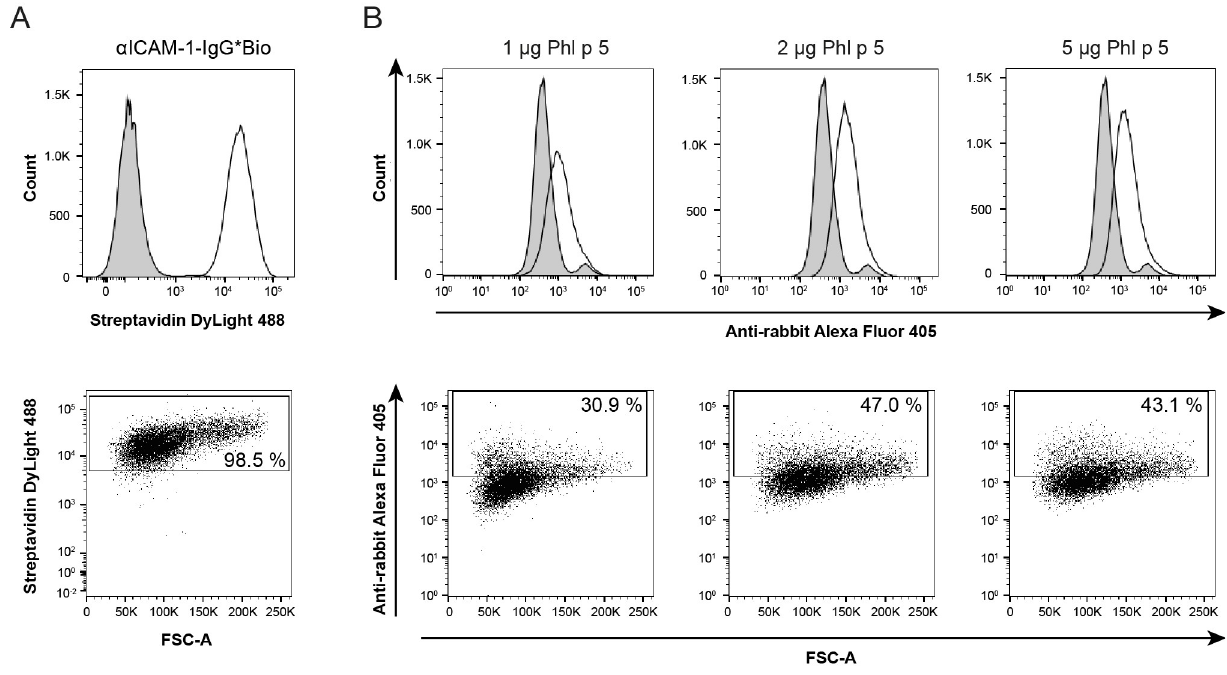
Figure 2. Detection of ICAM-1 or Phl p 5 captured by α Phl p 5/ α ICAM-1 conjugates on 16HBE14o- cells through flow cytometric analysis. ( A ) Expression of human ICAM-1 on the surface of 16HBE14o- cells was confirmed by using α ICAM-1-IgG*Bio ( upper panel: white) or an isotype control ( upper panel: gray) and is shown as the percentage of ICAM-1-positive cells out of the alive cells in the scatter plot ( lower panel). ( B ) Cells were incubated with α Phl p 5/ α ICAM-1 conjugates and different amounts of Phl p 5 (1 µ g/50 µ L, 2 µ g/50 µ L and 5 µ g/50 µ L) and were subsequently probed for α Phl p 5/ α ICAM-1-bound Phl p 5 with specific rabbit serum or pre-immune serum as an isotype control. Results are displayed as overlayed histograms of Phl p 5-specific rabbit serum (white) and the isotype control (gray) ( upper panels), or as percentages of Phl p 5-positive cells out of the alive cells in the scatter plots ( lower panels). Scatter plots depict the forward scatter (FSC-A) ( x -axes) against ( y -axes) ( A ) Steptavidin Dylight 488 and ( B ) anti-rabbit Alexa Fluor 405. Experiments were performed in triplicates, and displayed data are representatives of two independent